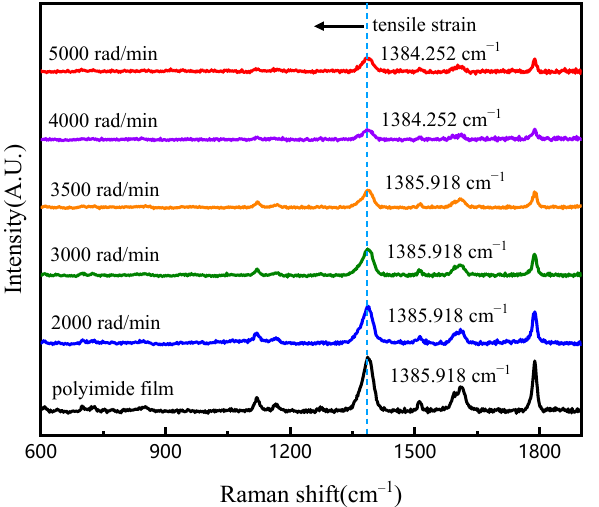
Figure 2. Raman spectra of polyimide film and polyimide films grown on the substrate with different spin-coating